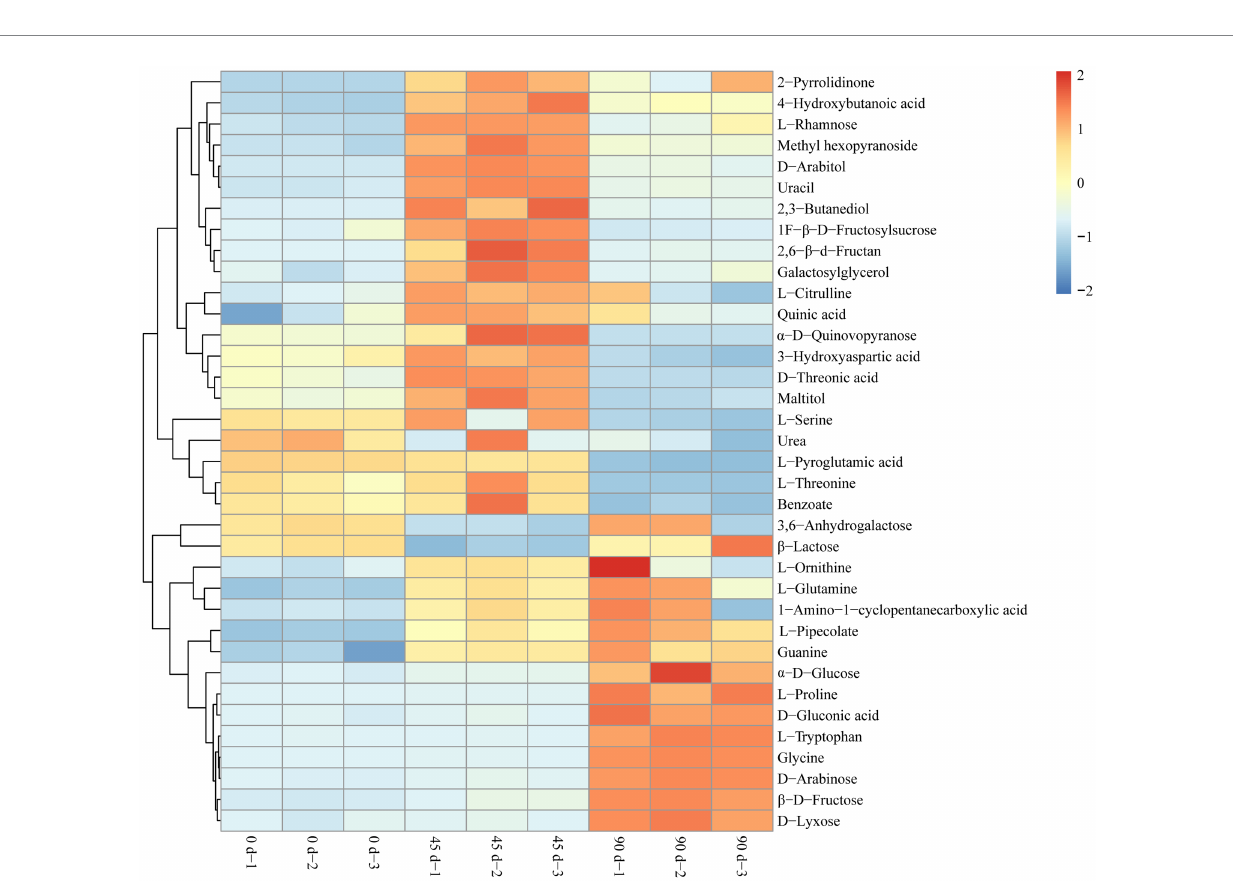
FIGURE 4 Hierarchical clustering analysis heat map of the main differential metabolites in LSCKs fermented for 0, 45, and 90